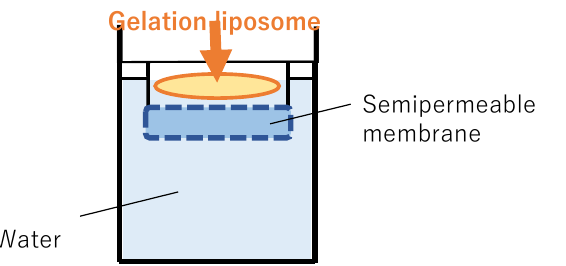
Gelation liposome